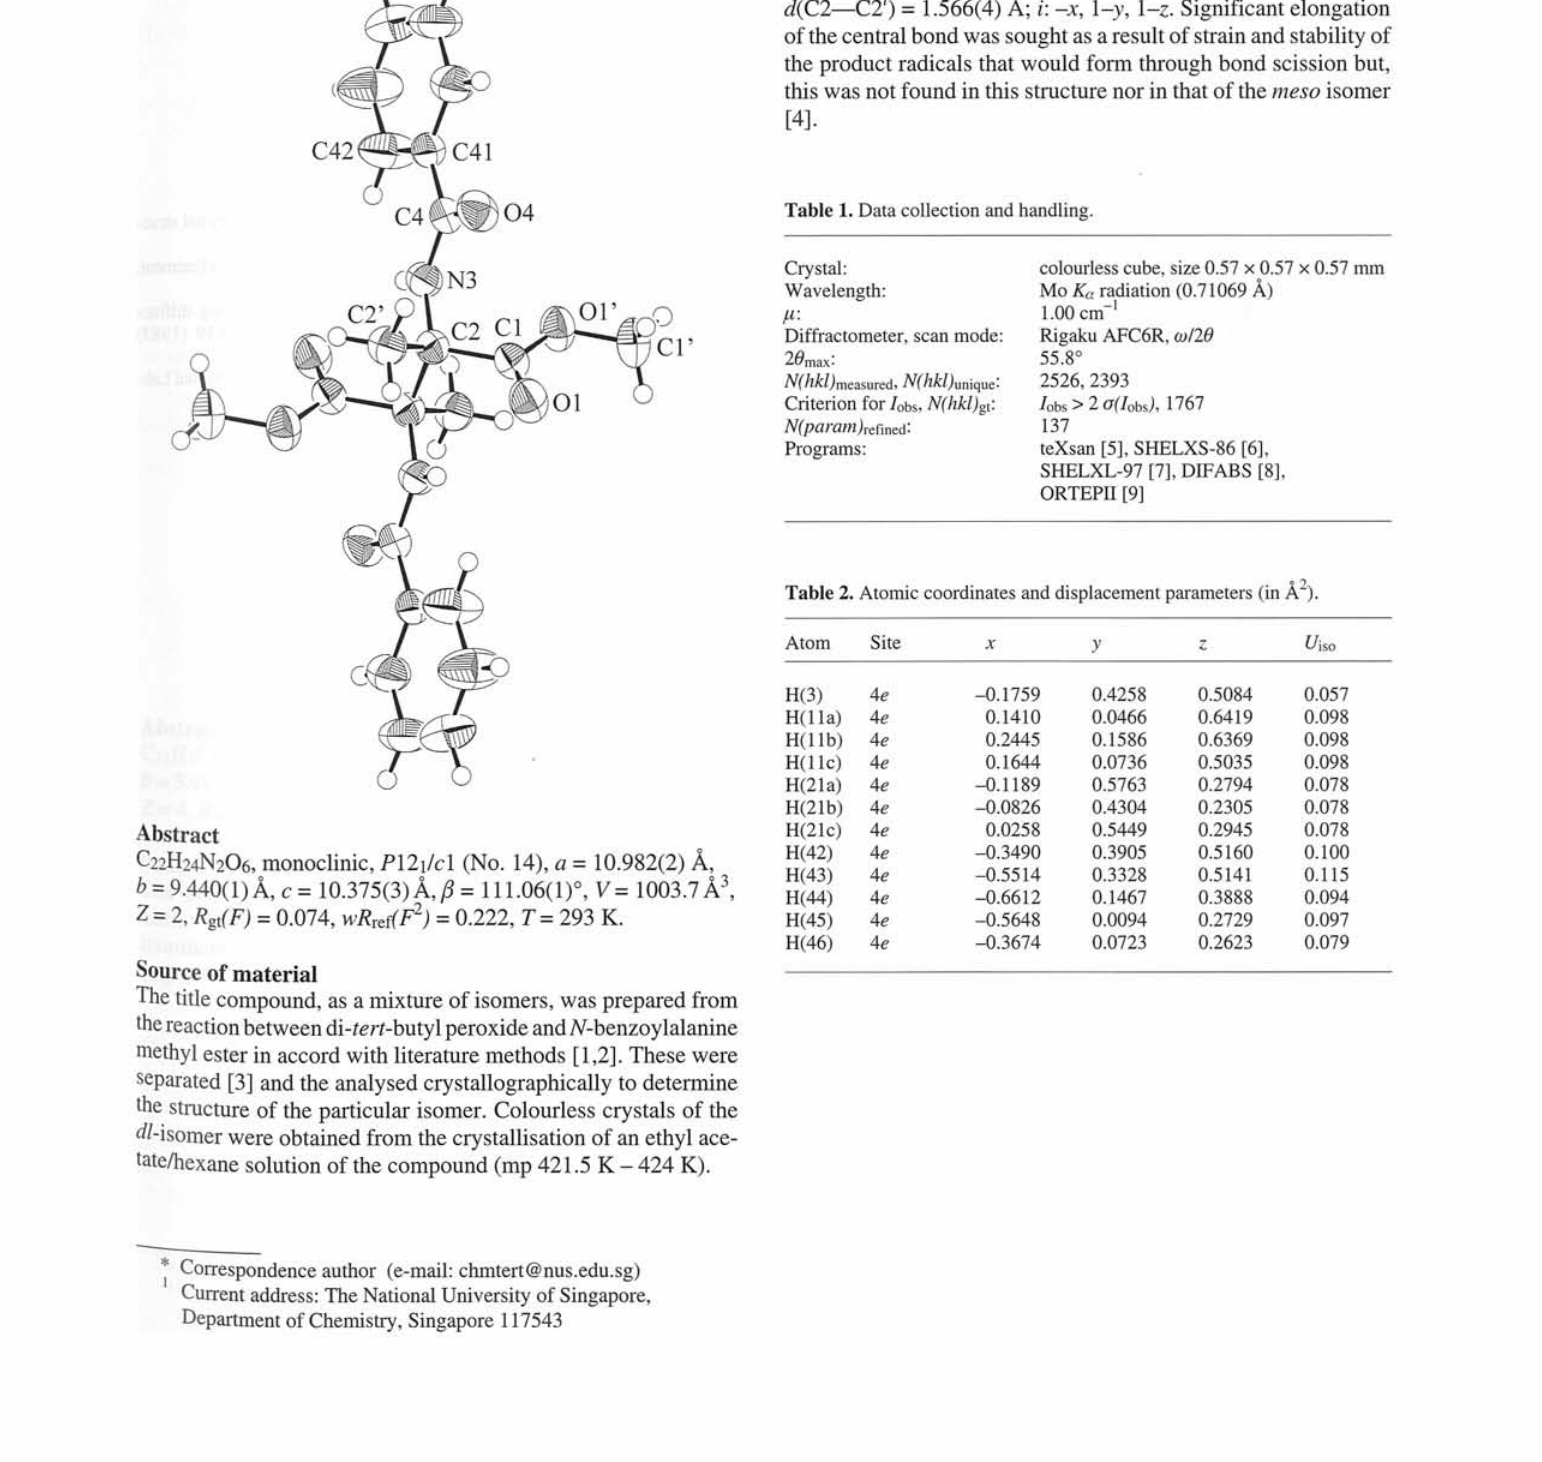
Table 1. Data collection and handling. Crystal: